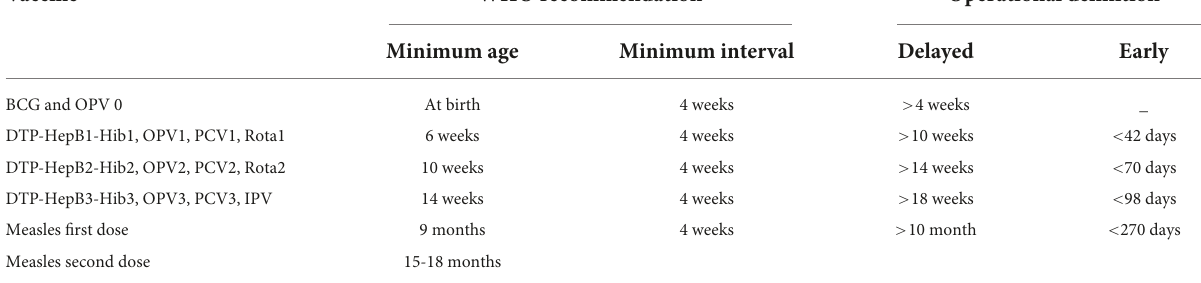
TABLE 1 National and WHO recommended vaccination